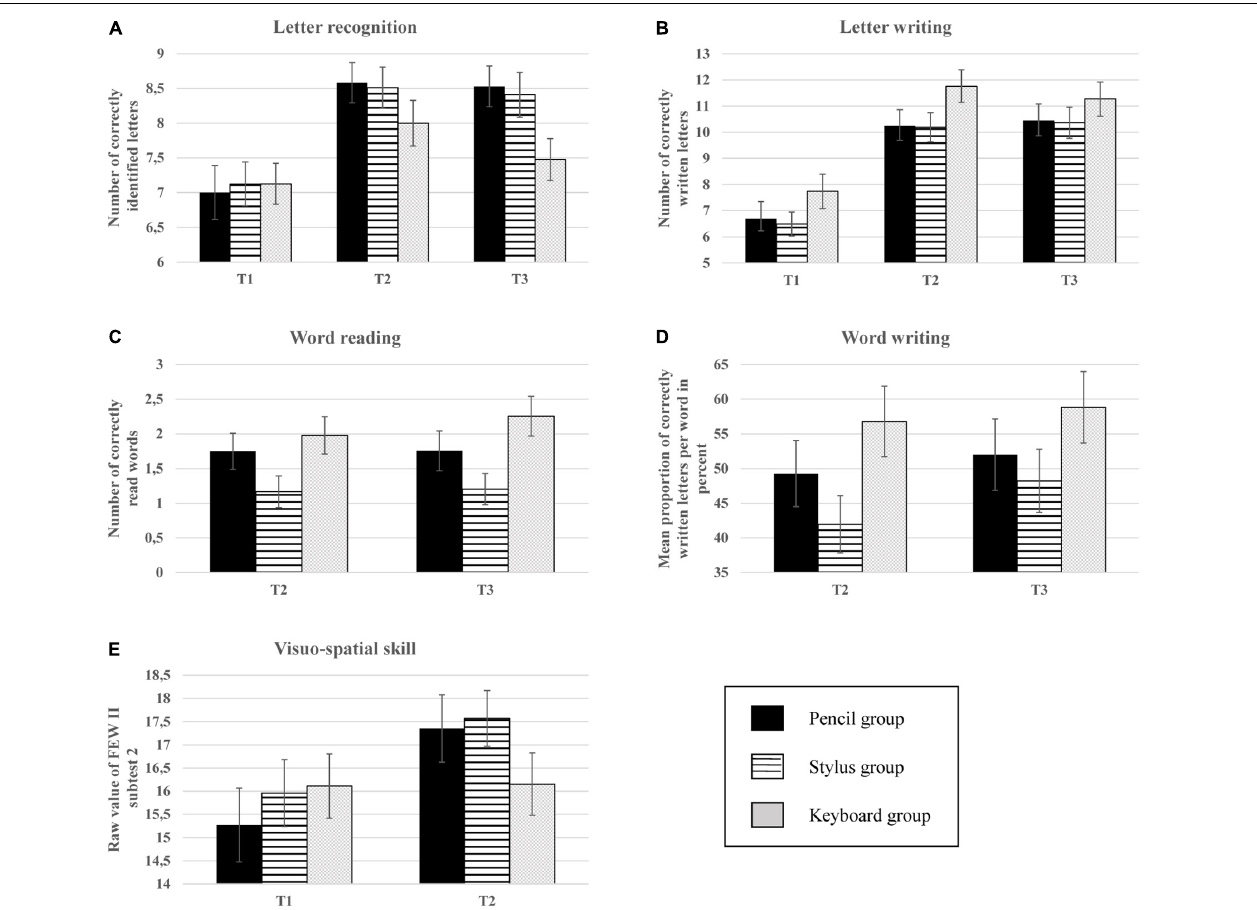
FIGURE 3 | The performance of the children in the different tests (letter recognition, letter writing, word reading, word writing, and visuo-spatial skill) separately for the three trainings groups (pencil group, stylus group, and keyboard group) as a function of time points of assessment (T1, T2, T3). Shown are mean scores (number of correct response: letter recognition, letter writing and word reading and visuo-spatial skill) or mean percentages scores (relative frequency of correct response: word writing). Top left (A) = letter recognition. Top right (B) = letter writing. Middle left (C) = word reading. Middle right (D) = word writing. Bottom left (E) = visuo-spatial